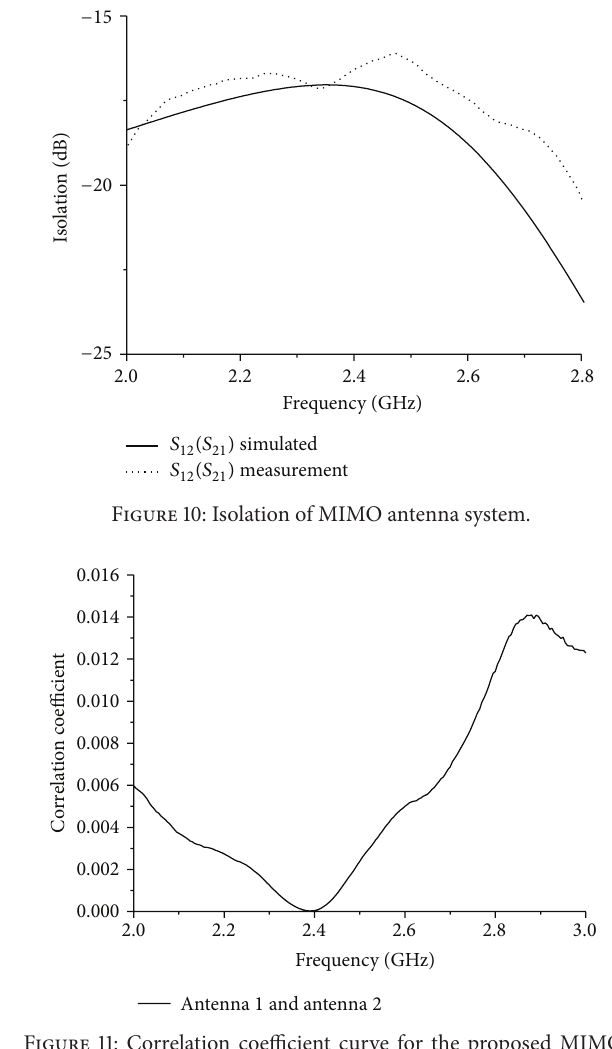
Figure 11: Correlation coefficient curve for the proposed MIMO antenna system.